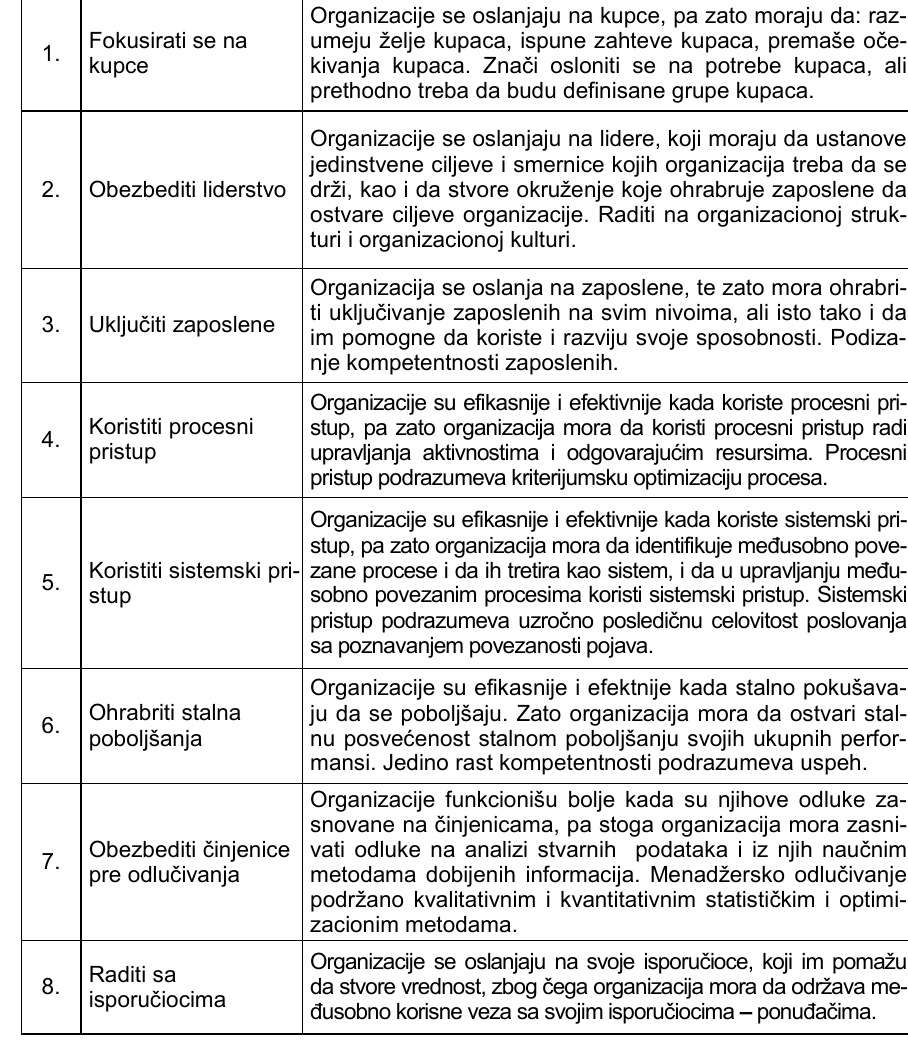
trebale da koriste period duži od 15 meseci. To zna č i da projekat mora imati jasno definisan cilj, vreme i troškove. Osnove sistema menadžmenta kvalitetom č ini osam principa, koje najviše rukovodstvo može da koristi u cilju poboljšavanja performansi si- stema. Oni č ine osnovu za standarde sistema menadžmenta kvalitetom u okviru standarda ISO 9000, datu u slede ć oj tabeli